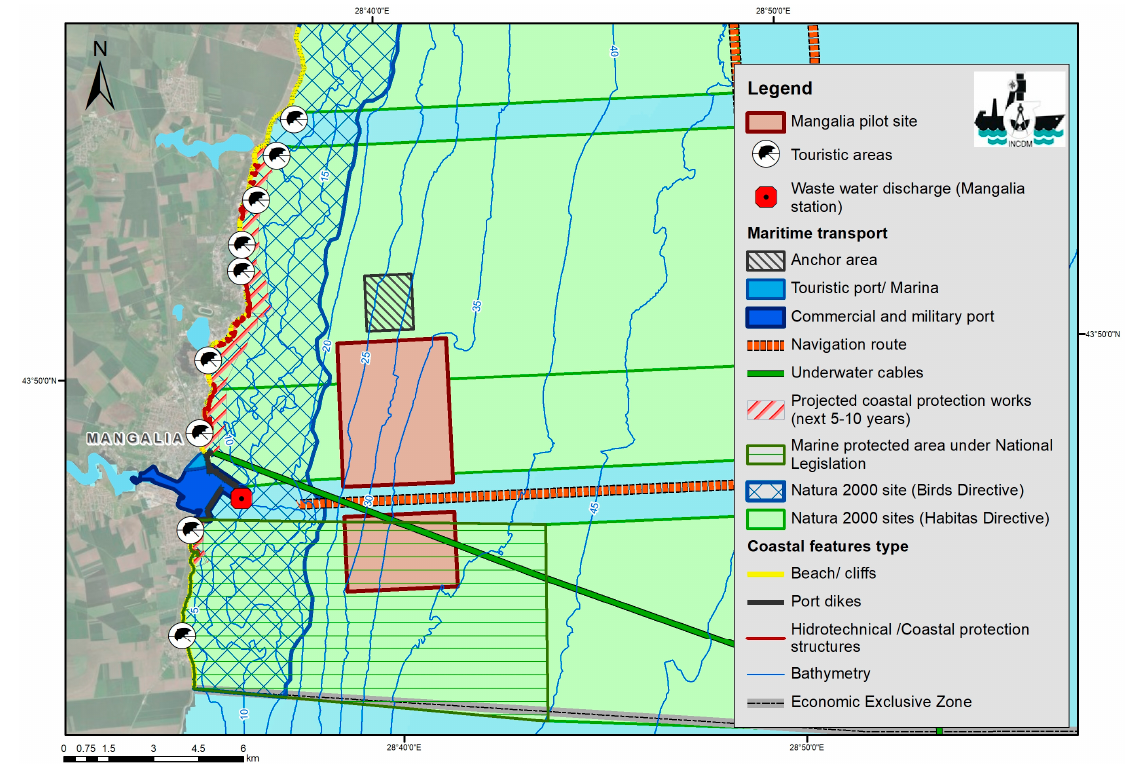
Figure 2. Integrated map of all uses of the maritime space in the Mangalia area, Romania .